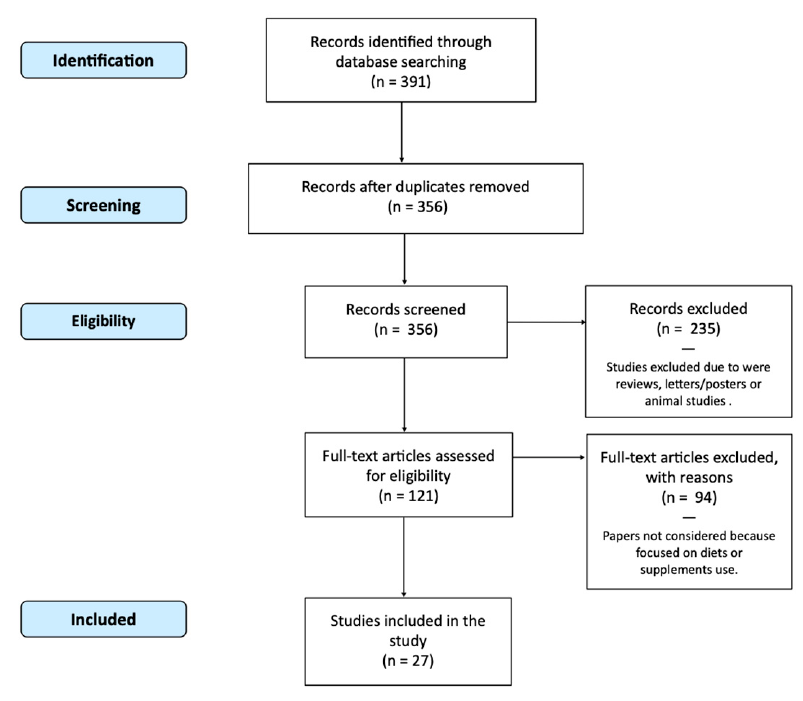
Figure 1. Flow Chart (PRISMA) of Studies Included.